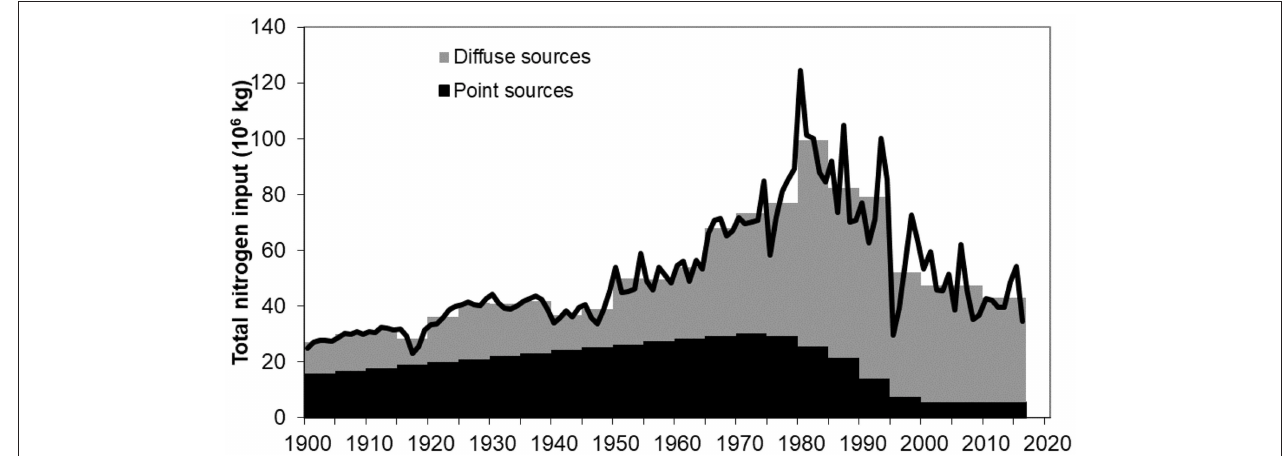
consequence of policies and implementation of measures targeting agriculture, industries and cities. Updated from Andersen and Conley